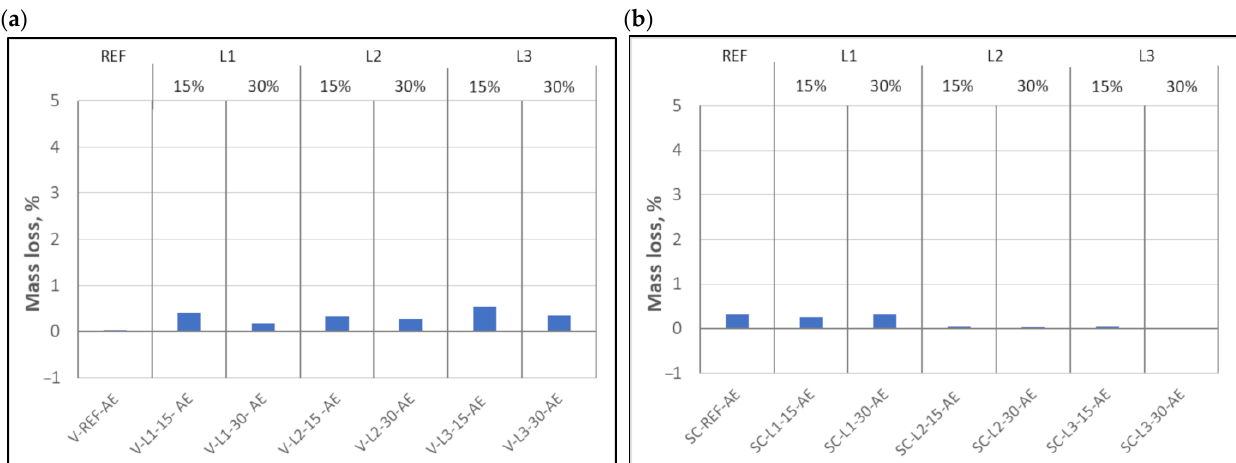
Figure 4. Mass loss of ( a ) vibrated and ( b ) self-compacting concrete without air-entraining admixture, after 100 freeze–thaw cycles.